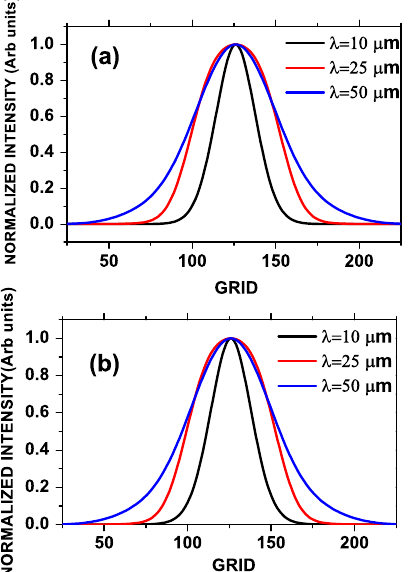
FIG. 1. For a cold, closed cavity in the confocal configuration, cross section of the transverse mode at the downstream mirror using (a) GENESIS + OPC , and (b) our analytic model.